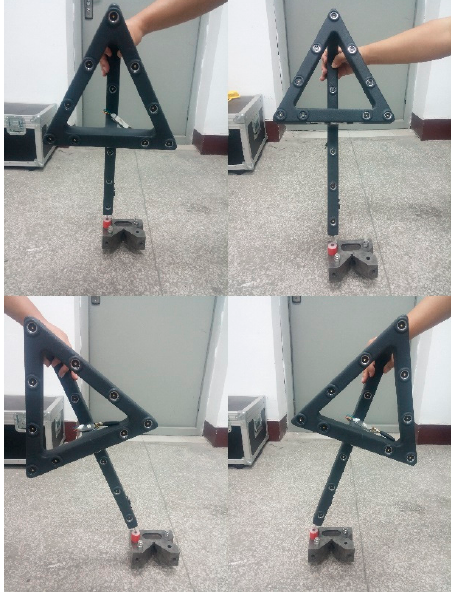
Figure 5. Four gestures for self-calibration.